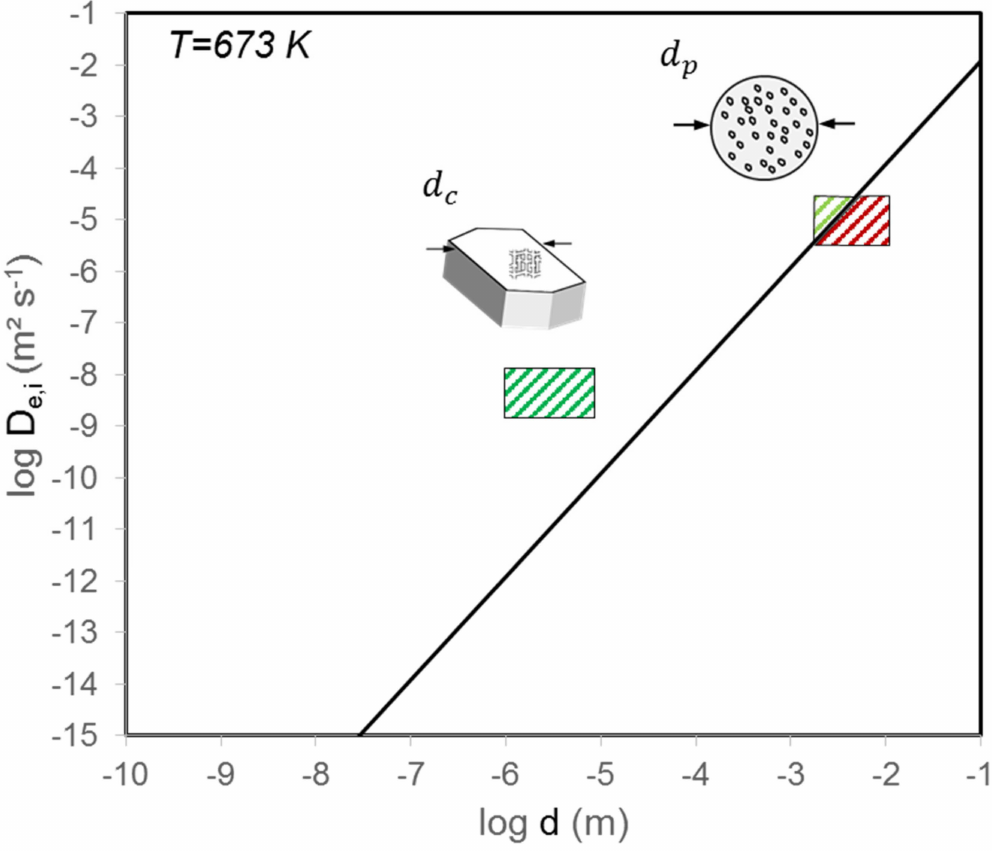
Figure 2. Internal mass transfer limitations assessed by the Weisz–Prater criterion (Equation (1)) in an industrial ethanol dehydration reactor as a function of particle diameter d, which can correspond either to the crystallite diameter, i.e., d c , or to the pellet diameter, i.e., d p , and the e ff ective di ff usion coe ffi cient D e,i . The black line indicates the criterion limit of 0.08. Boxes indicate the typical ranges of di ff usion coe ffi cient and diameter for either crystallite or pellet. (Green: no internal mass transport limitations; red: internal mass transport